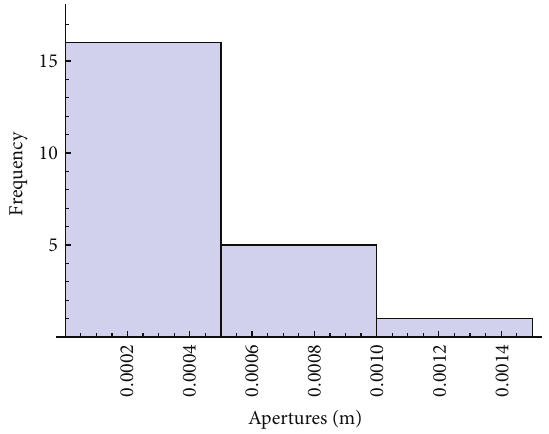
Figure 4: Histogram of the generated samples via Monte Carlo simulation of aperture (m).